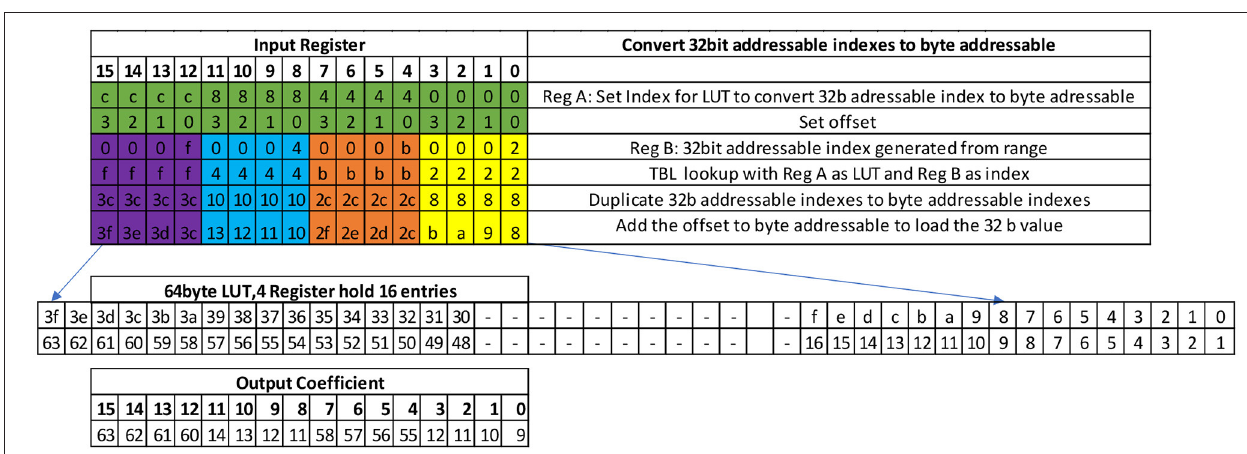
FIGURE 10 | Byte addressable table look up setup in ARM/AArch64. We highlight the conversion of 32bit indexes to byte indexes and the use of byte indexes to get the coefficients in 16 FP32